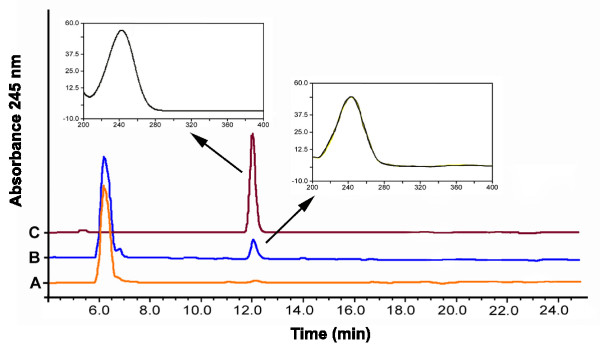
HPLC traces of potato leaf exudates. The terminal leaflets of potato leaves were excised from glasshouse plants, petioles were re-cut under water and the freshly cut end transferred to 200 μl 5 mM CaCl2 (trace A) or 200 μl 15 mM EDTA (trace B). Samples were transferred to a saturated atmosphere to exude in the dark for 90 min. The exudation medium was brought to 5% MPA, 5 mM TCEP, centrifuged and injected onto a Coregel 64H column. Traces were recorded at 245 nm using a diode array detector and insets show the absorbance spectra of the peaks at 12.2 min. Trace C was authentic AsA (2.27 nmol) which gave a peak height of 42 mAU. The unbound peak at 6.3 min contained MPA.